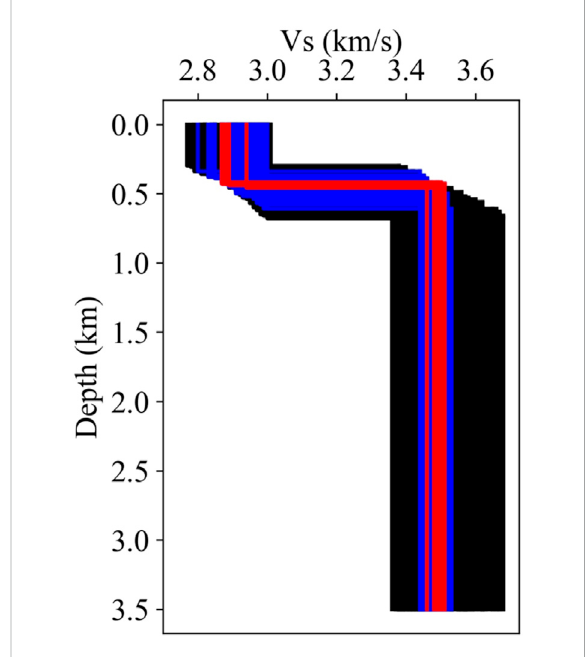
FIGURE 10 The inversion results with the subset data of the SP11 seismic data. The black lines are models obtained by the fundamental dispersion curve; blue lines are models obtained by the joint inversionofthefundamentaldispersion curveand thePg and Sg traveltimes; and red lines are models obtained by the joint inversion of the fundamental and fi rst dispersion